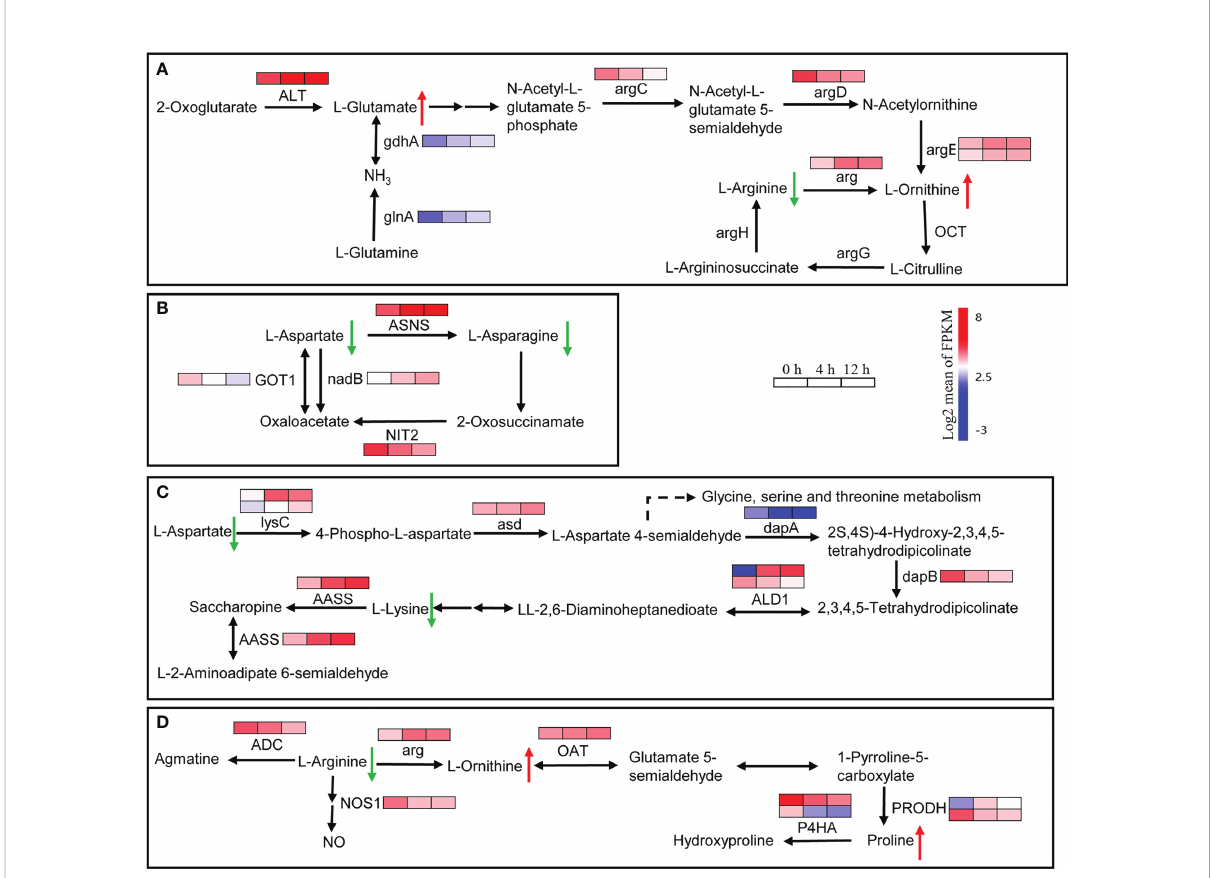
FIGURE 8 Expression heatmaps of genes involved in the selective amino acid metabolism pathway. (A) Changes in the expression of genes involved in glutamine, ornithine and arginine metabolism. ALT, alanine transaminase; argC, N -acetyl- g -glutamyl-phosphate reductase; argD, acetylornithine aminotransferase; argE, acetylornithine deacetylase; argG, argininosuccinate synthase; arg, arginase; OCT, ornithine carbamoyltransferase; argH, argininosuccinate lyase; glnA, glutamine synthetase; gdhA, glutamate dehydrogenase. (B) Changes in the expression of genes involved in aspartate and asparagine metabolism. ASNS, asparagine synthase (glutamine-hydrolyzing); nadB, L-aspartate oxidase; GOT1, aspartate aminotransferase, cytoplasmic; NIT2, w -amidase. (C) Changes in the expression of genes involved in aspartate and lysine metabolism. lysC, aspartate kinase; asd, aspartate-semialdehyde dehydrogenase; dapA, 4-hydroxy-tetrahydrodipicolinate synthase; dapB, 4-hydroxy- tetrahydrodipicolinate reductase; ALD1, LL-diaminopimelate aminotransferase; AASS, a -aminoadipic semialdehyde synthase. (D) Changes in the expression of genes involved in arginine, ornithine and proline metabolism. ADC, arginine decarboxylase; arg, arginase; OAT, ornithine aminotransferase; PRODH, proline dehydrogenase; P4HA, prolyl 4-hydroxylase; NOS1, nitric oxide synthase. Genes that changed signi fi cantly in at least one time point after salt treatment are